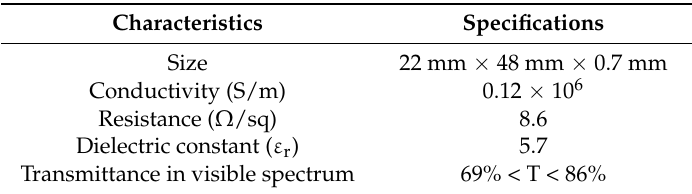
Figure 3. Metal Electrode HBC module and Transparent Electrode HBC module. Table 2. Specifications of transparent electrode.